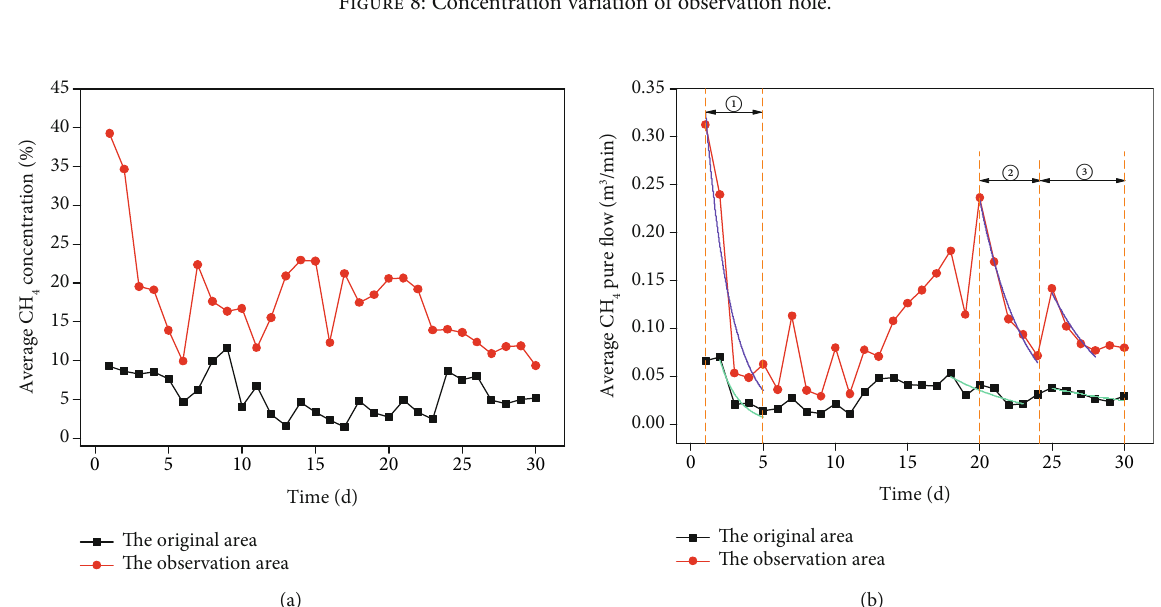
Figure 9: Correlation diagram between average gas drainage concentration and average gas drainage